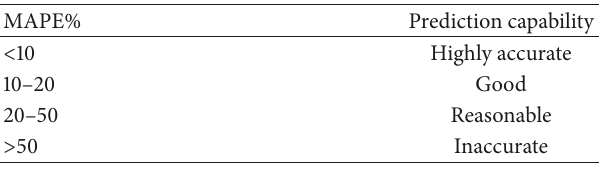
Table 4: Prediction accuracy level divided by MAPE value.